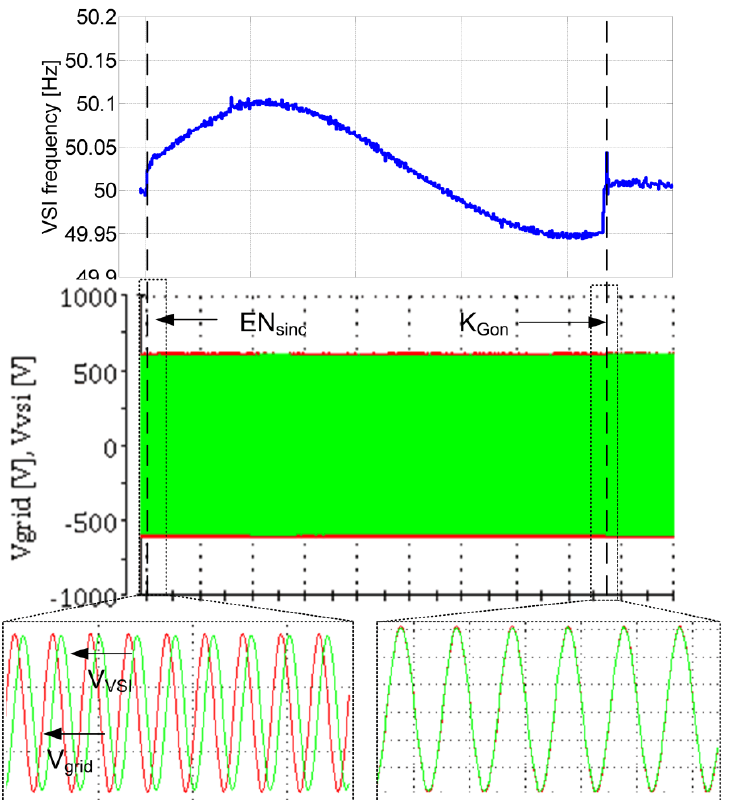
Figure 7. Synchronization process detailing.